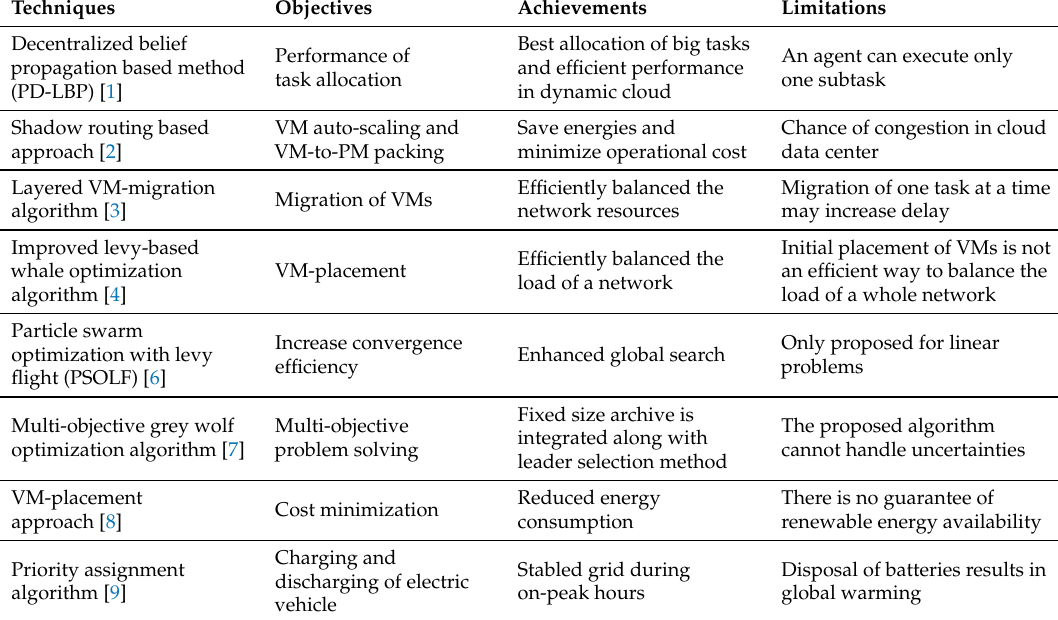
Table 1. Related